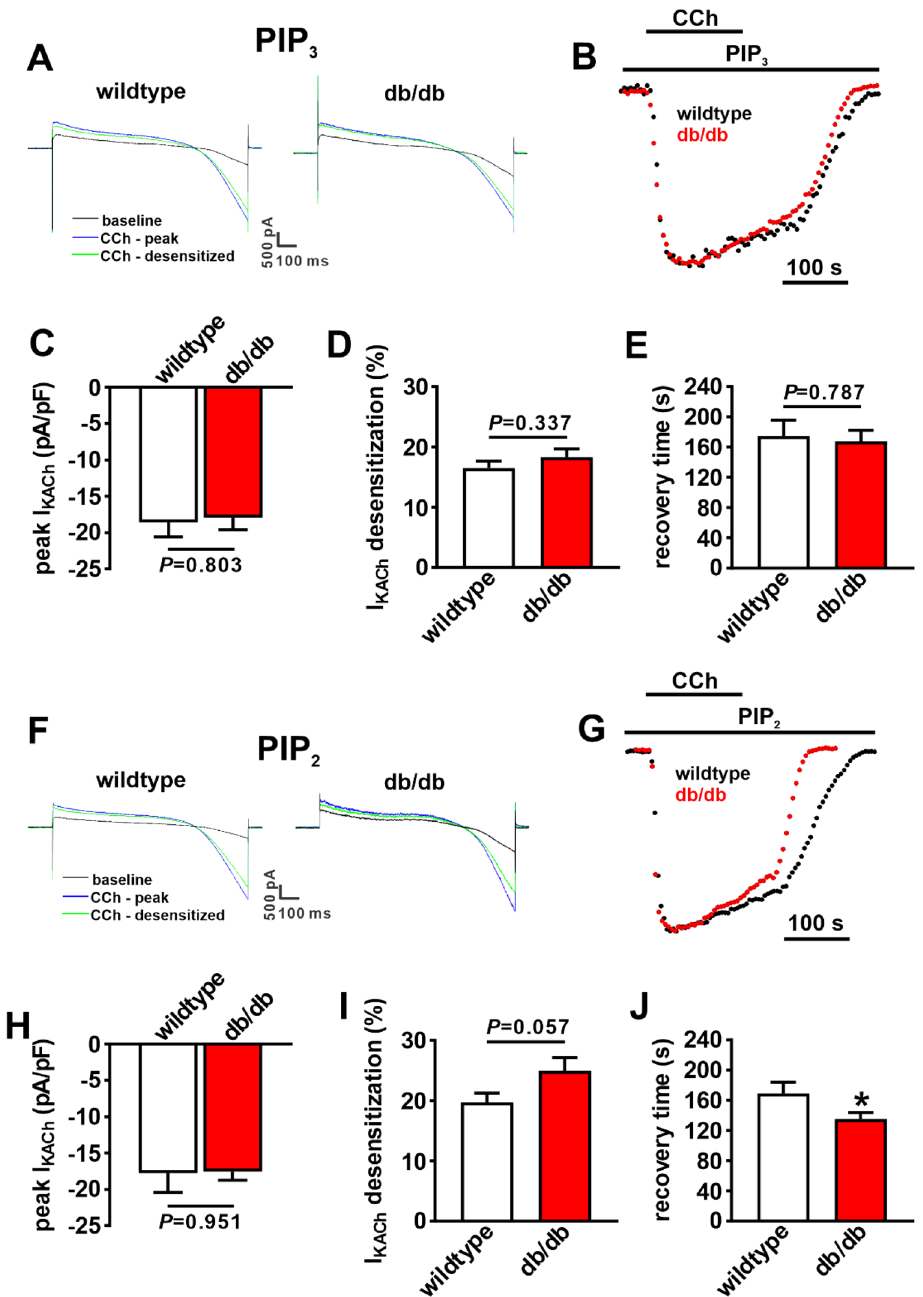
Figure 8. Effects of PIP 3 on I KACh kinetics in db/db SAN myocytes. ( A ) Representative I K recordings illustrating peak and desensitized responses to CCh in wildtype and db/db SAN myocytes dialyzed with PIP 3 (1 µM). ( B ) Time course of CCh stimulated I KACh , measured at − 100 mV, in wildtype and SAN myocytes dialyzed with PIP 3 . ( C-E ) Summary of peak I KACh at − 100 mV ( C ), I KACh desensitization ( D ) and I KACh recovery time during CCh washoff ( E ) in wildtype ( n = 16) and db/db ( n = 19) SAN myocytes dialyzed with PIP 3 . Data in panels ( C – E ) analyzed by Student’s t -test. ( F ) Representative I K recordings illustrating peak and desensitized responses to CCh in wildtype and db/db SAN myocytes dialyzed with PIP 2 (1 µM). ( G ) Time course of CCh stimulated I KACh , measured at − 100 mV, in wildtype and SAN myocytes dialyzed with PIP 2 . ( H – J ) Summary of peak I KACh at − 100 mV ( H ), I KACh desensitization ( I ) and I KACh recovery time during CCh washoff ( J ) in wildtype ( n = 18) and db/db ( n = 19) SAN myocytes dialyzed with PIP 2 . For panels ( H – J ) * P < 0.05 by Student’s t